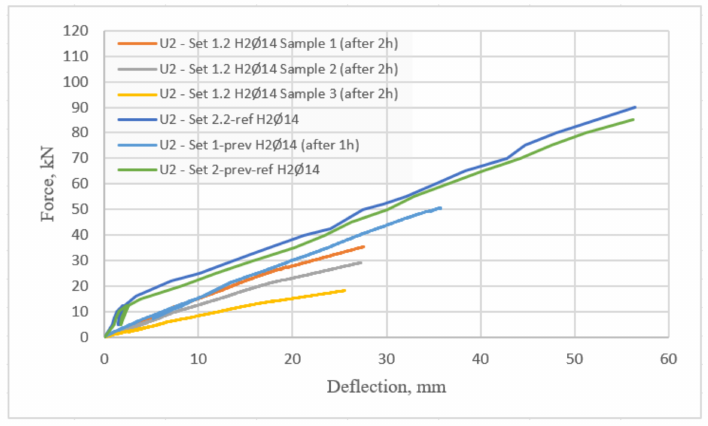
Figure 12. Comparison of ultimate strength capacity values for tested HFRP-RC beams from the current study (set 1.2) with outcomes obtained for reference beams (set 2.2) and results from the previous study (set 1-prev, set 2-prev-ref for HFRP-RC